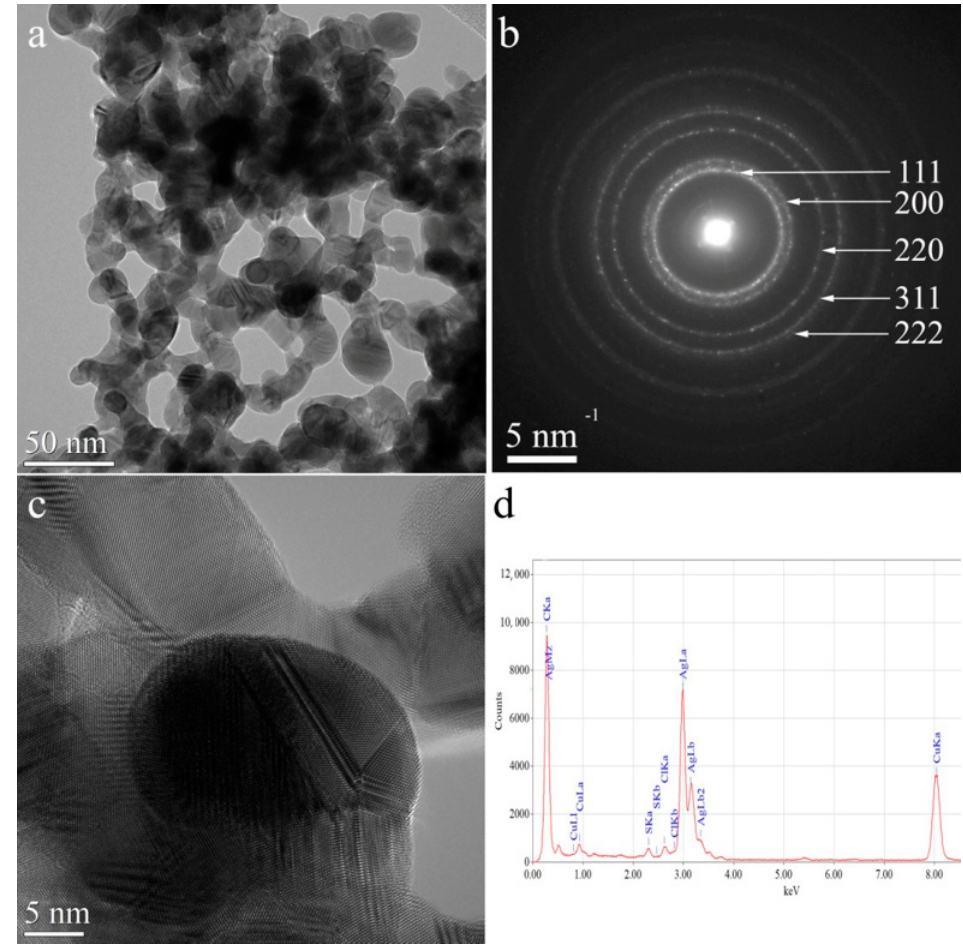
Figure 8. ( a ) CTEM image of AgNPs/L-cys/citr; ( b ) SAED pattern; ( c ) HRTEM image; ( d ) EDS spectrum.